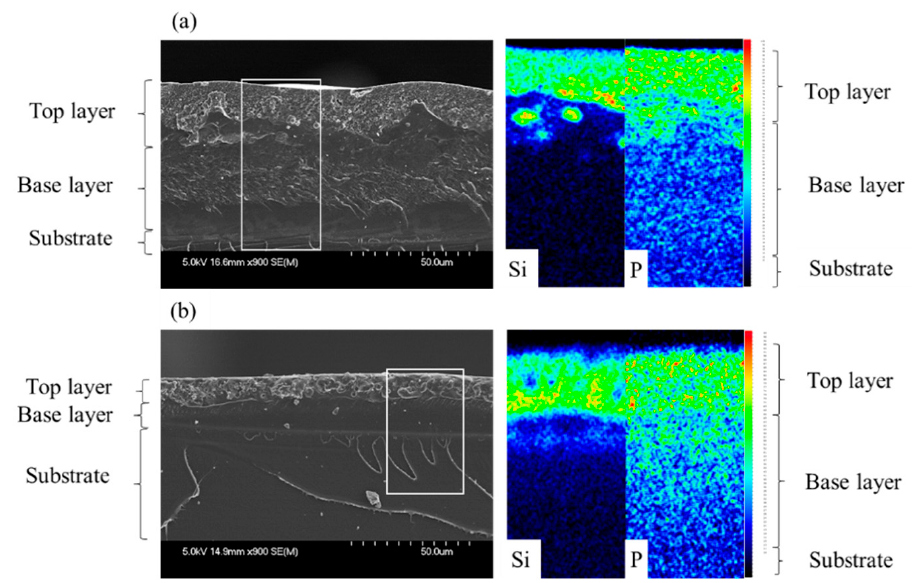
Figure 2. EDS X-ray mappings of Silicon and Phosphorus on a cross-section of an epoxy/silicone coating filled with 5 wt.% of ( a ) resorcinol bis(diphenyl phosphate) (RDP) and ( b ) bisphenol-A- bis(diphenyl phosphate) (BDP) additives.